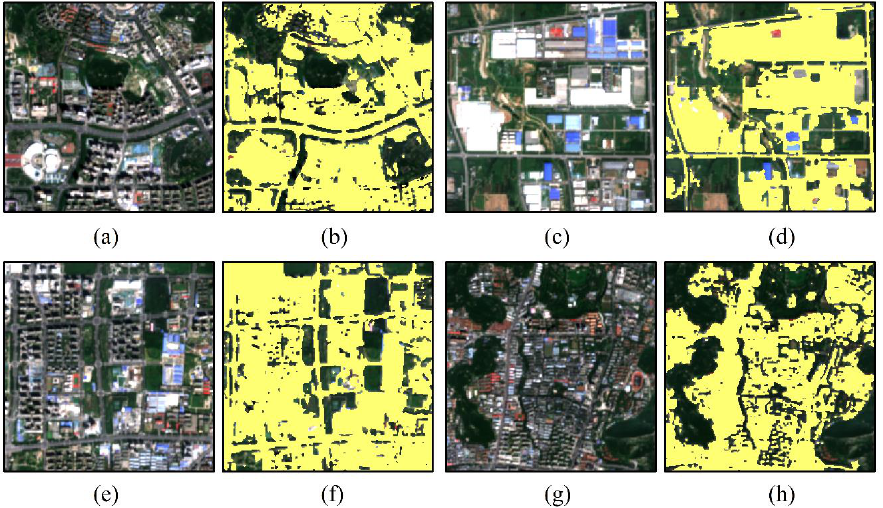
Figure 9. Local ISA distribution for ( b ) sub-region I; ( d ) sub-region II; ( f ) sub-region III; and